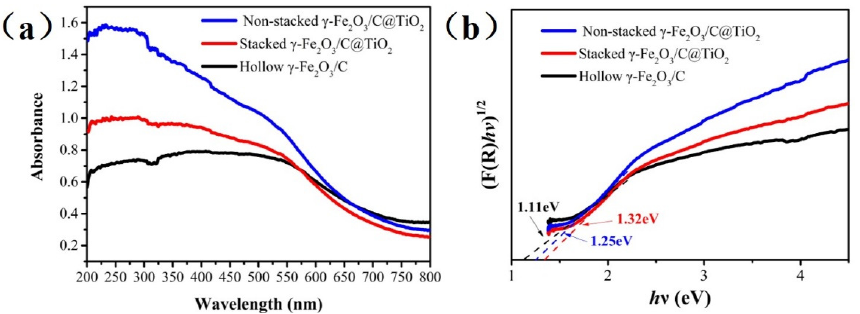
Figure 6. UV-Vis diffuse reflectance spectra ( a ) and calculated band gap patterns based on UV-Vis diffuse reflectance spectra ( b ) of non-stacked γ -Fe 2 O 3 /C@TiO 2 , stacked γ -Fe 2 O 3 /C@TiO 2 , and hollow γ -Fe 2 O 3 /C.